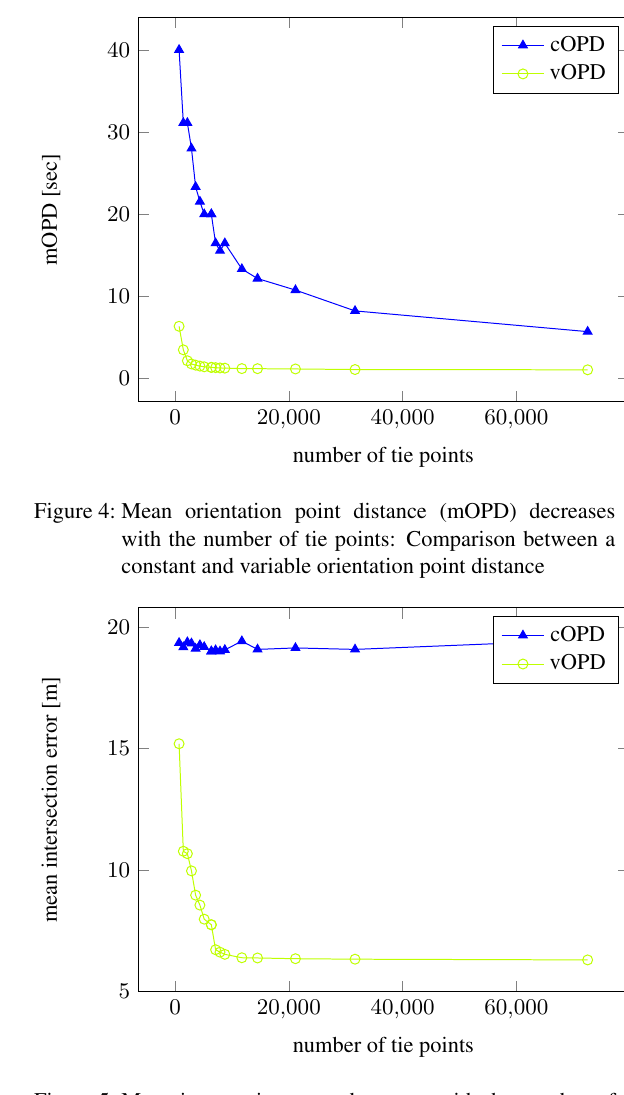
Figure 5: Mean intersection error decreases with the number of tie points: Comparison between a constant and variable orientation point